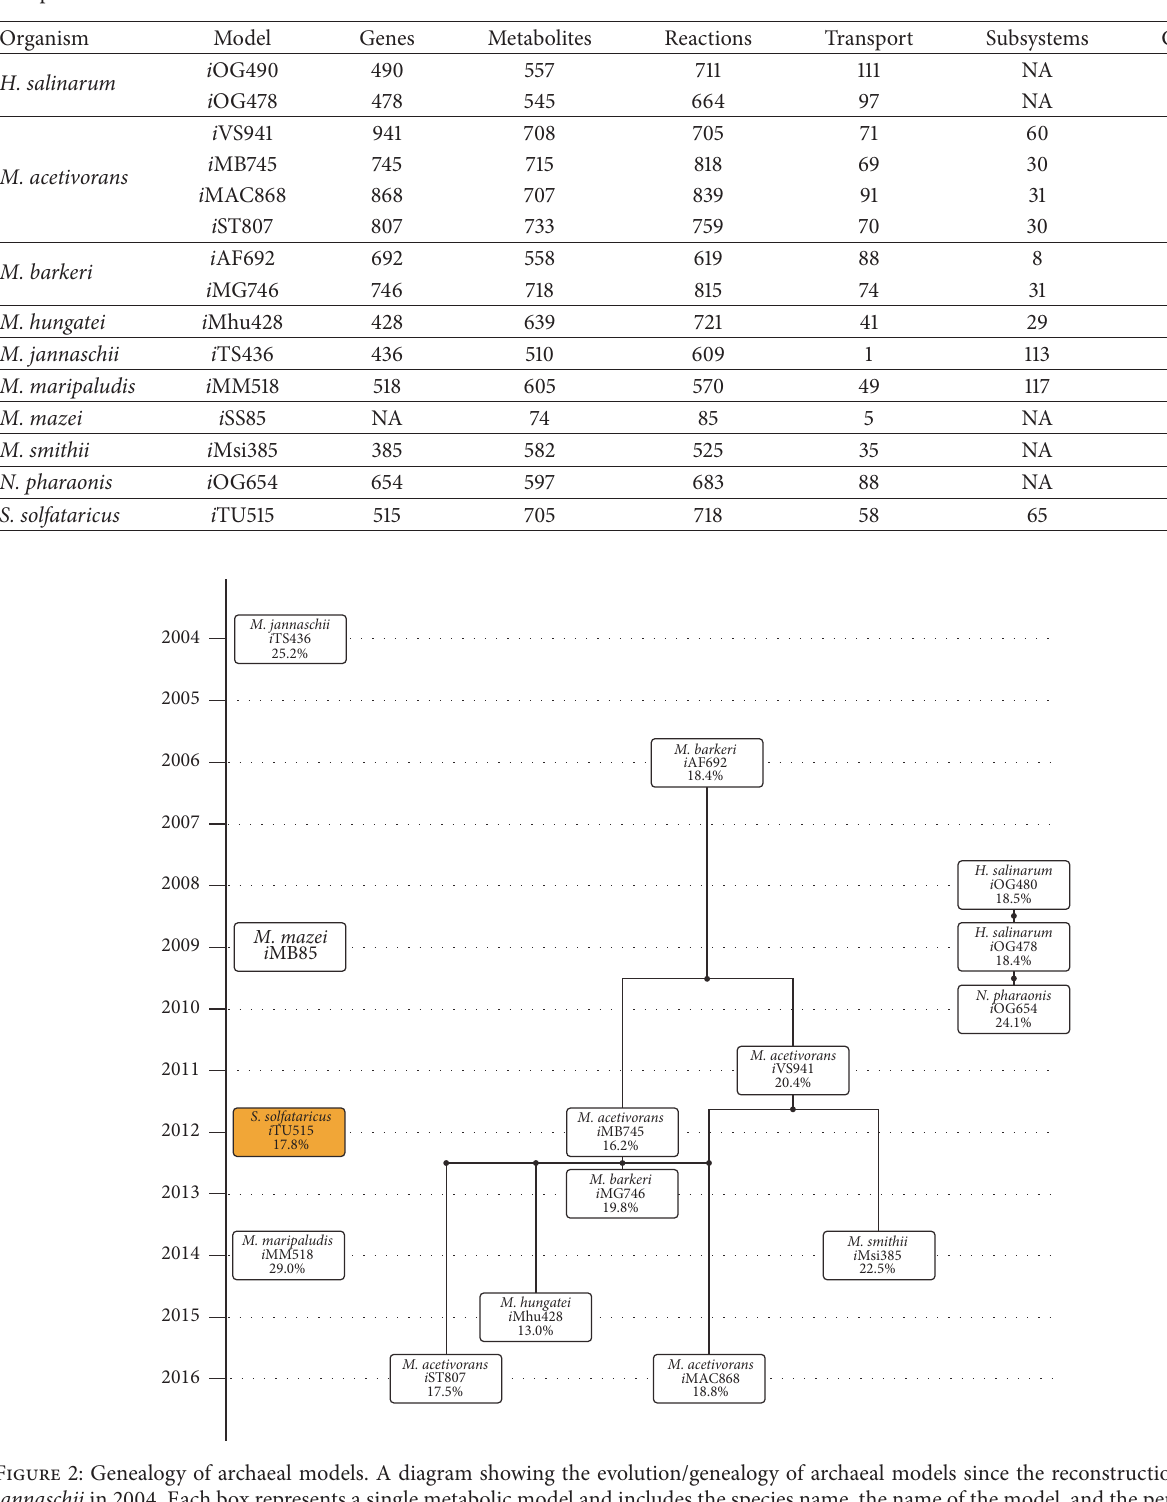
Figure 2: Genealogy of archaeal models. A diagram showing the evolution/genealogy of archaeal models since the reconstruction of M. jannaschii in 2004. Each box represents a single metabolic model and includes the species name, the name of the model, and the percentage of protein coding genes (where available) that are incorporated in the model. The sole representative of the Crenarchaeota kingdom [28] is highlighted in